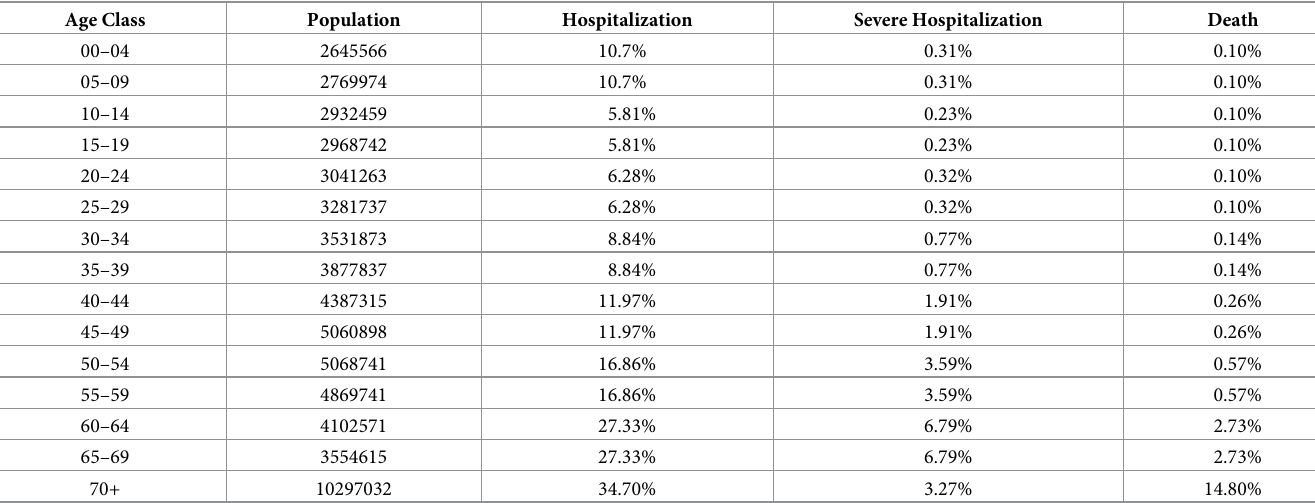
Table 1. Population in the different age classes (Source: [60]). COVID-19 hospitalization, severe hospitalization and death rates as of April 2021 (source: [59]).